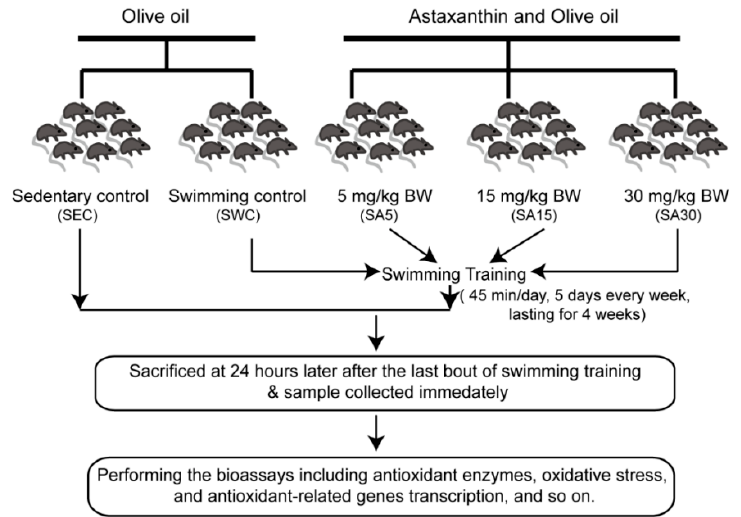
Figure 1. The experimental design and flow diagram for evaluation of astaxanthin.